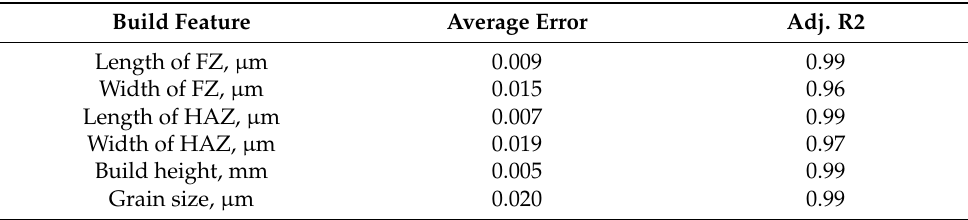
Table 2. Average error in predictions and correlation coefficient values of various deposit parameters of the DED-processed Ti–6Al–4V alloy